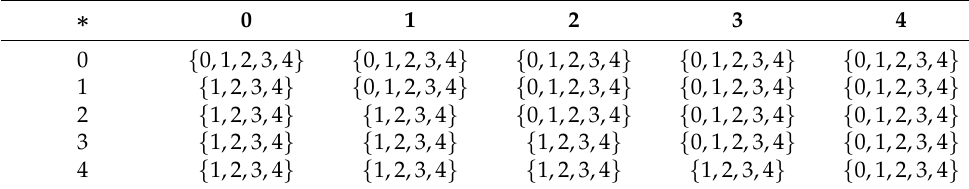
Table 5. Quasi-hyper BZ -algebra.